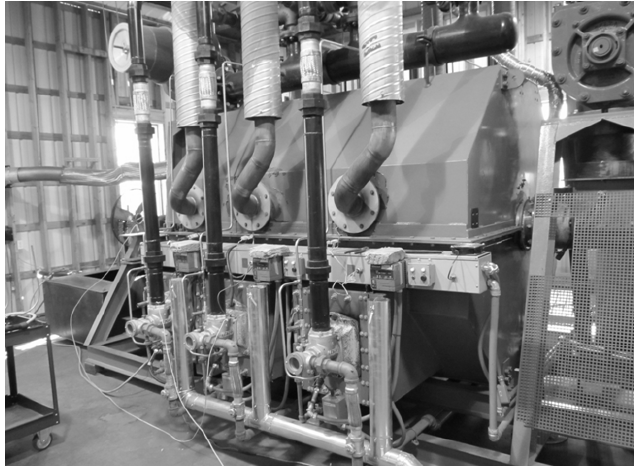
Figure 1. The Tucker Engineering Associates (TEA) gasifier used in this study. Photo: